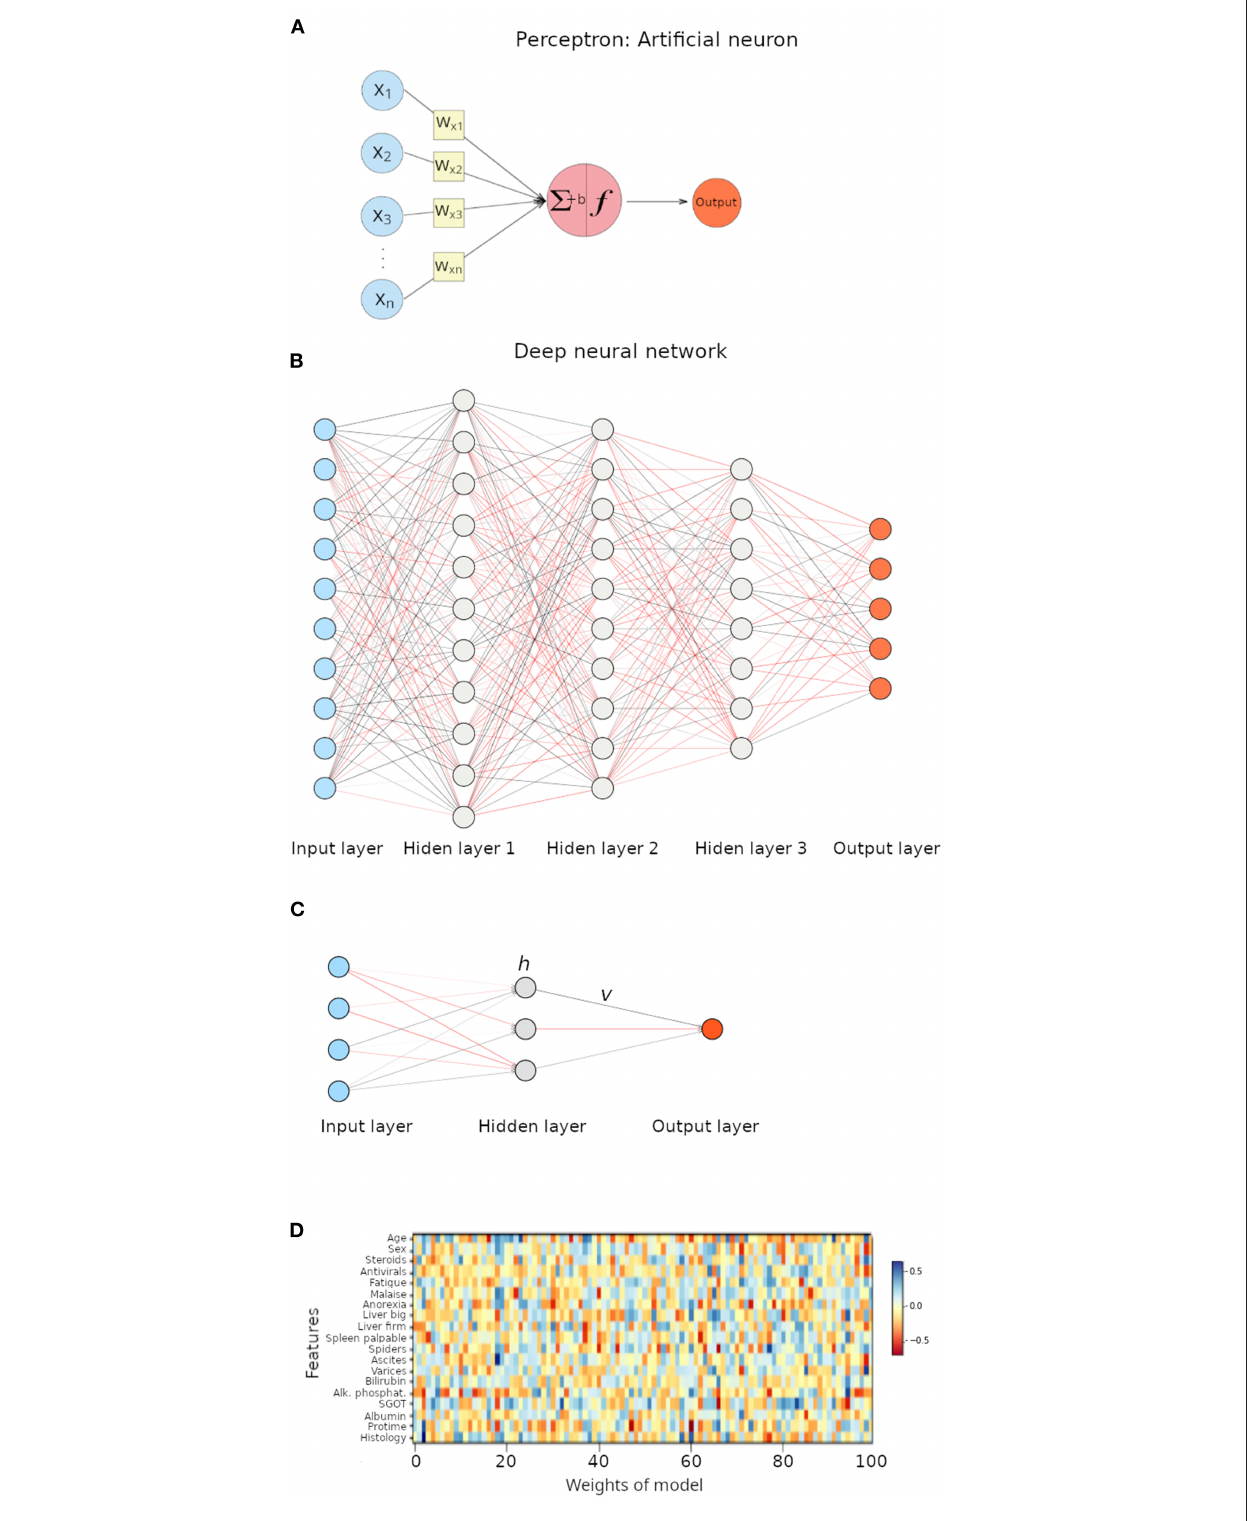
FIGURE 3 | Illustration of artificial neural networks (ANNs). (A) Perceptron, a neural network with a single neuron. activation function, and b represents the bias term. (B) Deep neural network with three hidden layers. Each interconnected node represents a neuron. (C) Neural network with a single hidden layer. (D) Heat map representation of weights in the multilayer perceptron model applied to the hepatitis dataset.